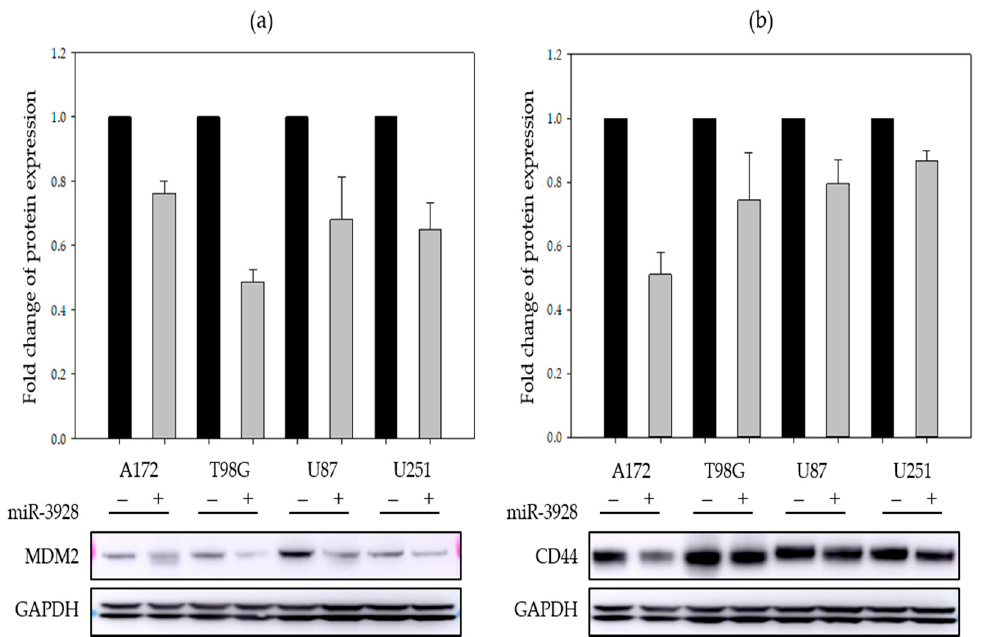
Figure 5. MiR-3298 inhibits the expressions of MDM2 and CD44 in GBM cells. ( a ) Band intensities from immunoblot replicates are quantified and graphed for A172, T98G, U87, and U251 cells transfected with either miRNA scrambled control ( − ) or miR-3928 (+). Representative immunoblot images for MDM2 and associated GAPDH are shown below the bar graph. ( b ) Band intensities from immunoblot replicates are quantified and graphed for A172, T98G, U87, and U251 cells transfected with either miRNA scrambled control ( − ) or miR-3928 (+). Representative immunoblot images for CD44 and associated GAPDH are shown below the bar graph. For each cell line, the miR-3928 average band intensities are normalized to the miRNA scrambled control band intensities.